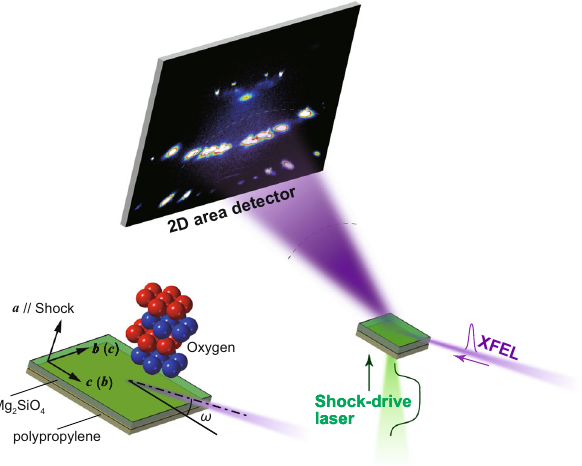
Fig. 1 Experimental system. The α − Mg 2 SiO 4 single crystal was shock- compressed along its crystallographic a -axis by irradiation of the power laser pulse into an ablator of polypropylene fi lm, where the crystal structure was simultaneously analysed using the XFEL pulse. A thin polycrystalline Al 2 O 3 plate (not shown) was fi xed on the upper surface of α − Mg 2 SiO 4 when the shock arrival time was